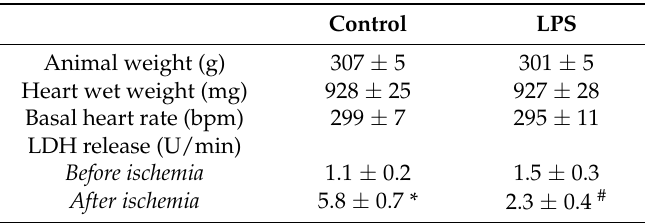
Table 1. Morphological parameters and LDH release.